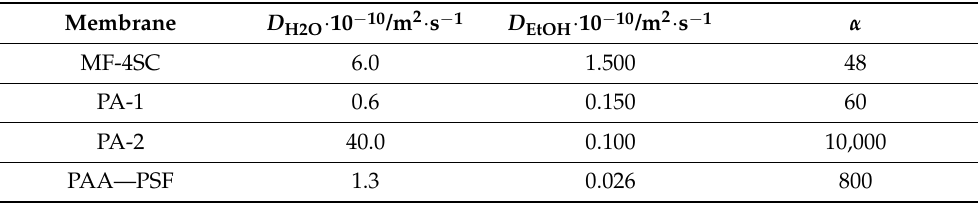
Table 11. Partial diffusion coefficients of water and ethanol and separation factor ( α ) of their mixture in membranes at 50 ◦ C